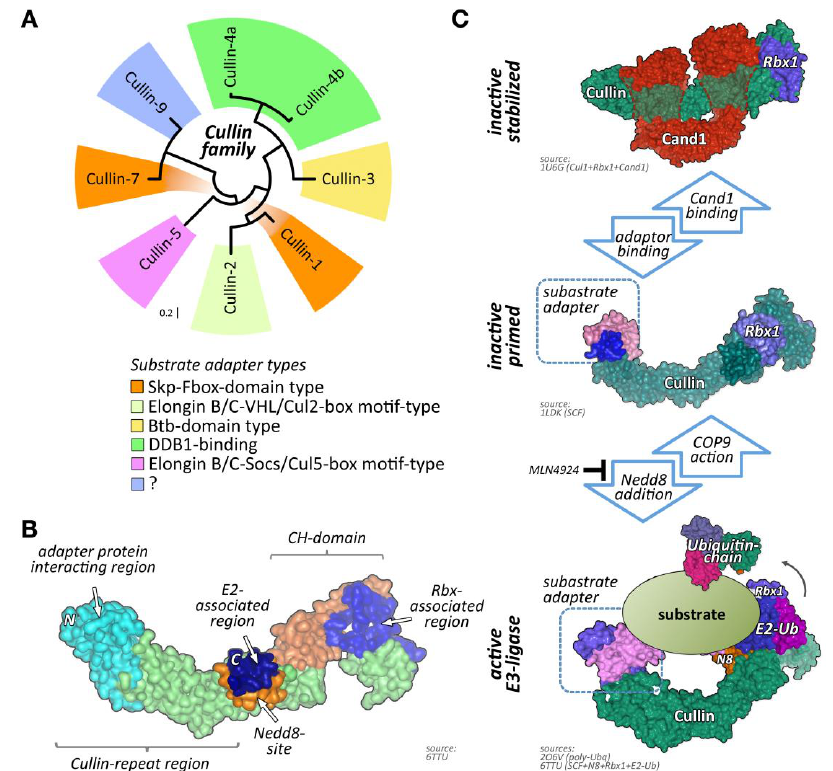
Figure 1. Cullin E3-ligases, domain overview, and activation. ( A ) Maximum likelihood molecular phylogenetic tree analysis of human cullin CH (cullin homology) domains. Shown are substrate adapter types for each of the cullin family members. ( B ) Schematics of cullin domain architecture, substrate adapter, and Rbx1 binding interfaces as well as the Nedd8-site in cullin-1. Surface representation of structure 6TTU [10]. ( C ) Simplified overview of cullin E3-ligase activation and substrate ubiquitylation. Inactive cullin bound to Rbx1 is stabilized by Cand1. Release of Cand1 allows for substrate adapter binding, “priming” the E3-ligase for a specific subset of substrate proteins. Adapter bound cullin gets fully activated by neddylation (N8), a step that is inhibited by Mln4924. Rbx1 associates with a ubiquitin loaded E2-enzyme. Binding of a substrate protein to the substrate adapter initiates the (poly-) ubiquitylation reaction. Cullin E3-ligases get inactivated by Cop9 signalosome action or enzymatic cleavage of Nedd8 by deneddylating enzymes Senp8 or Usp21. Surface representation of structures 1U6G, 1LDK, 6TTU, and 2O6V